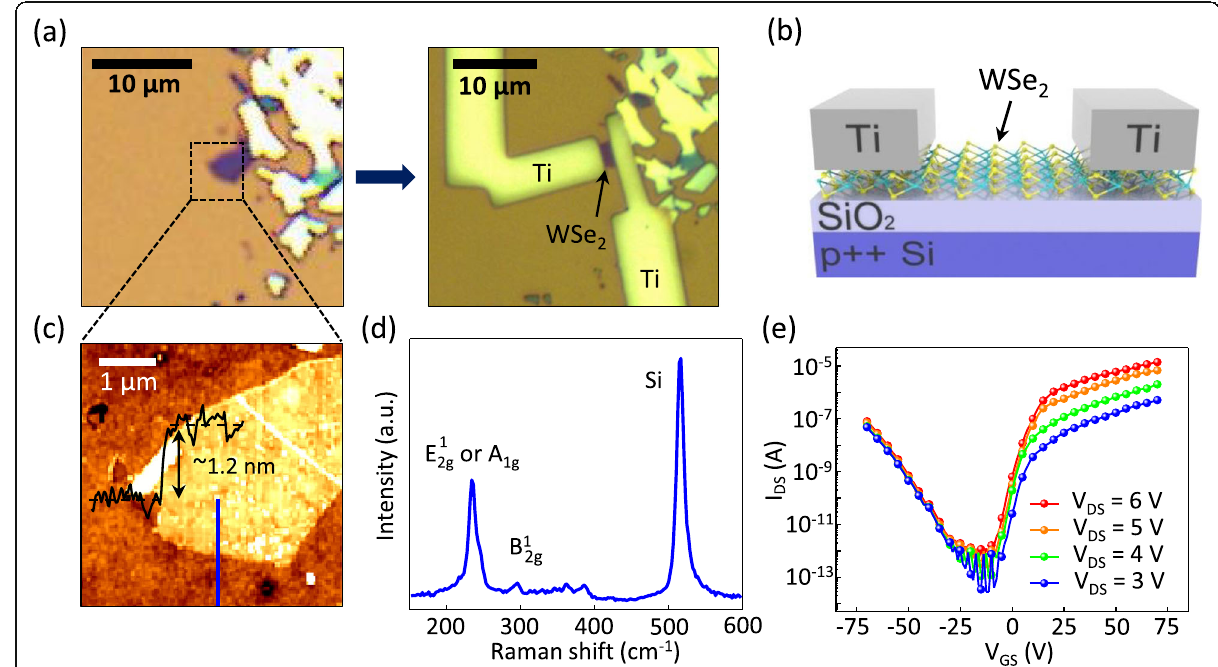
Fig. 1 a Optical images of a WSe 2 flake (left) and fabricated WSe 2 FET (right). b Schematic of the fabricated WSe 2 FET with Ti contacts. c AFM image and d Raman spectra of WSe 2 . e I DS - V GS curves of the ambipolar WSe 2